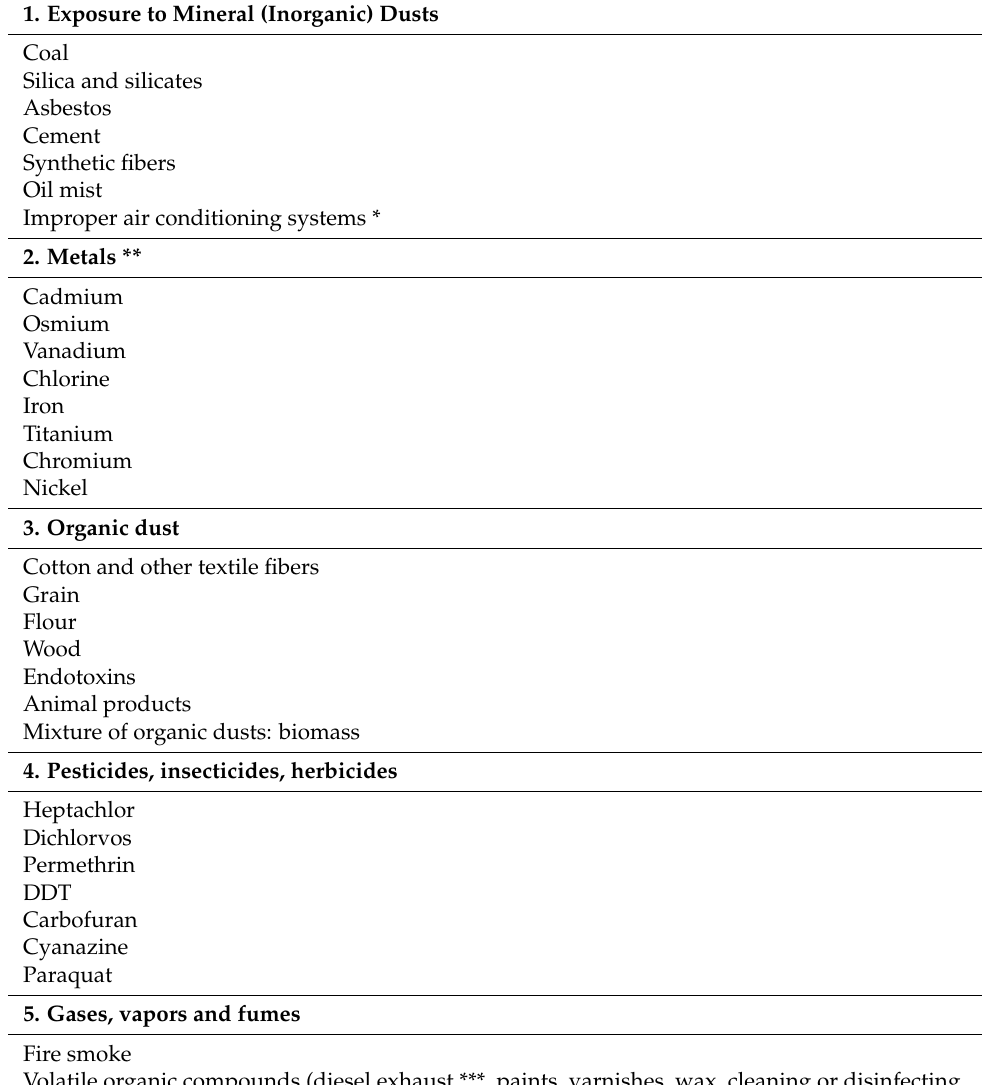
Table 1. Common workplace hazards associated with occupational